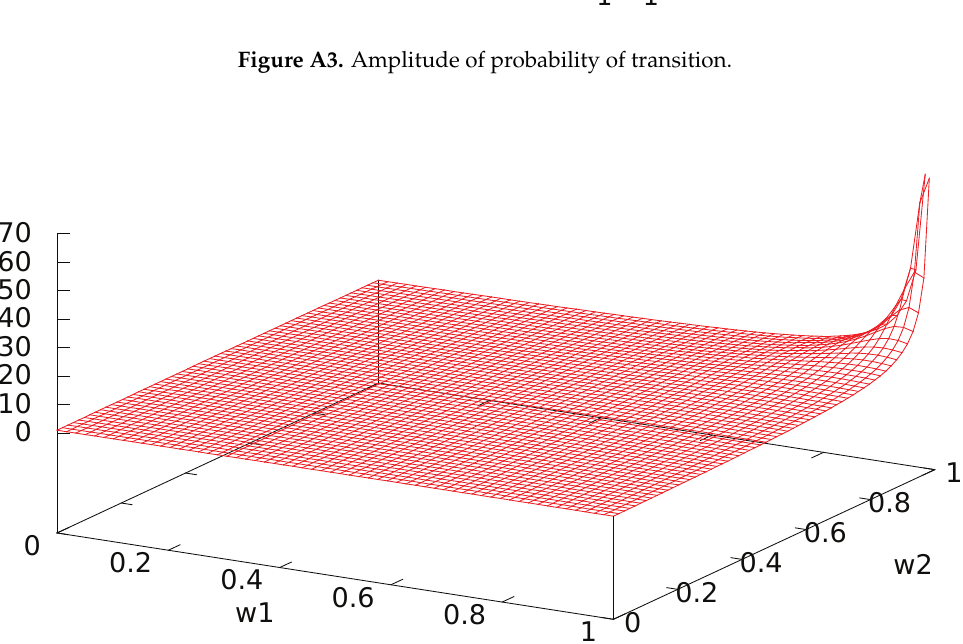
Figure A4. Period of probability of transition in π ¯ h units of